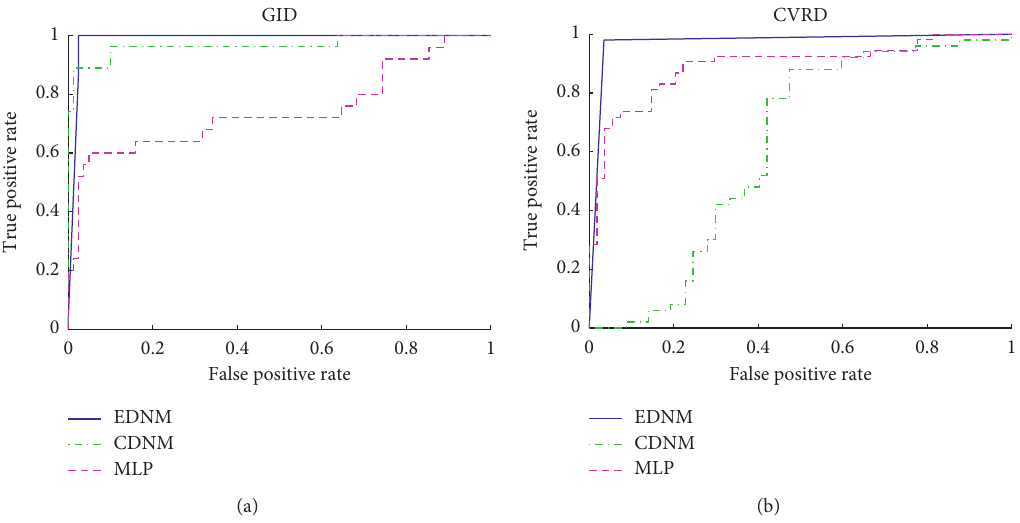
Figure 7: The AUC curves of EDNM, CDNM, and MLP for GID and